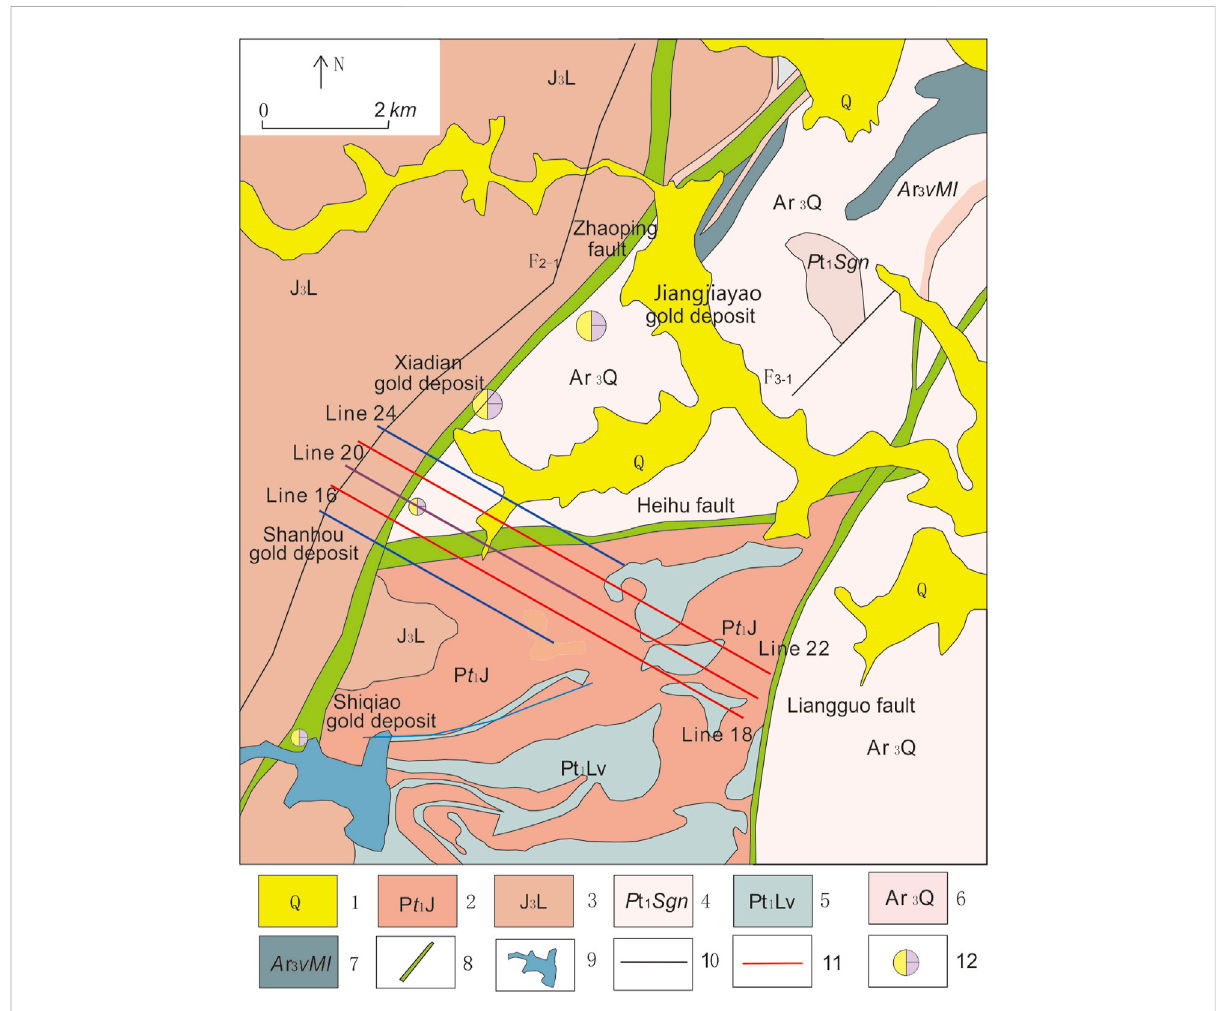
FIGURE 2 Simpli fi ed regional geological map of Shanhou gold deposit. 1- Quaternary; 2- Paleoproterozoic Jinshan Group; 3- Late Jurassic Linglong granite; 4- Paleoproterozoic Shuangdingshan gneiss; 5- Paleoproterozoic Penglai metabasite; 6- Archean Qixia gneiss; 7-Archean Luanjiazhai metabasite; 8- Deep-seated fault; 9-Reservoir; 10- Secondary fracture; 11- Geophysical pro fi le; 12- Gold deposit.